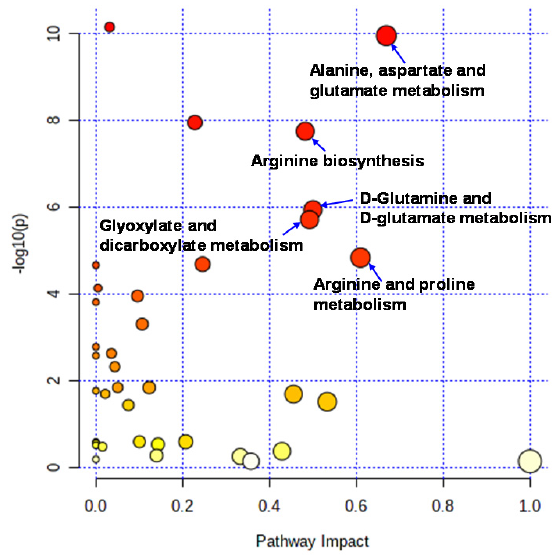
Figure 2. Pathways analysis. Pathway analysis was conducted to evaluate the pathway-level change between PRE and POST. The X -axis indicates pathway impacts. The Y -axis indicated − log 10 (P) of each pathway.